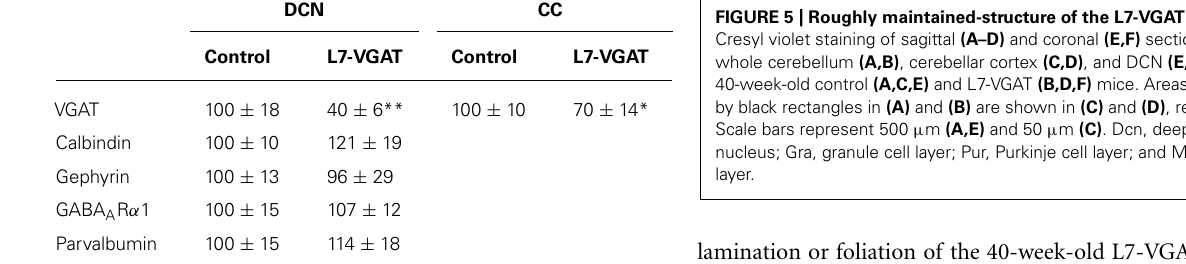
lamination or foliation of the 40-week-old L7-VGAT cerebellum